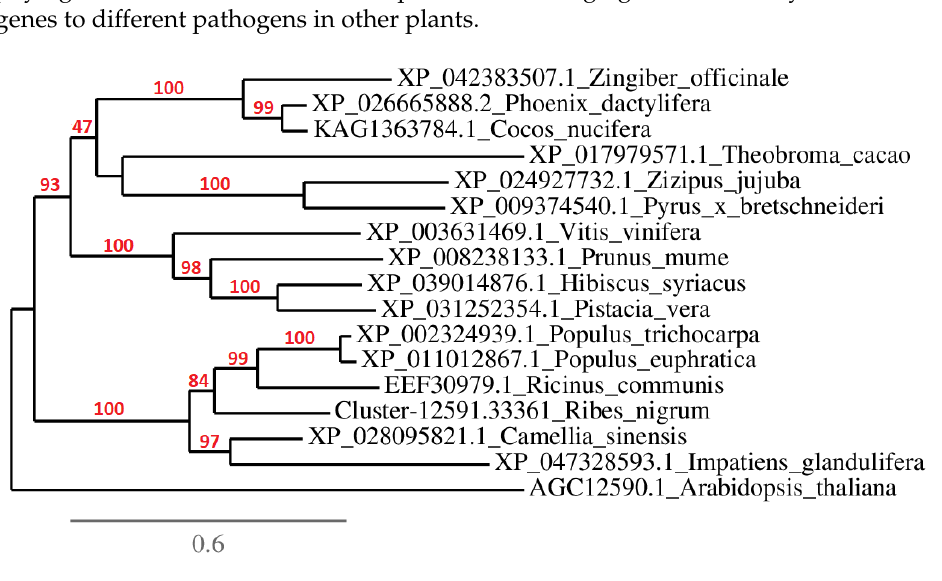
Figure 6. Phylogenetic tree of 17 RPM1 homologs at the amino acid level in different plant species, performed using the PhyML program. The labels of members in the phylogenetic tree consist of accession numbers in NCBI database_plant species.